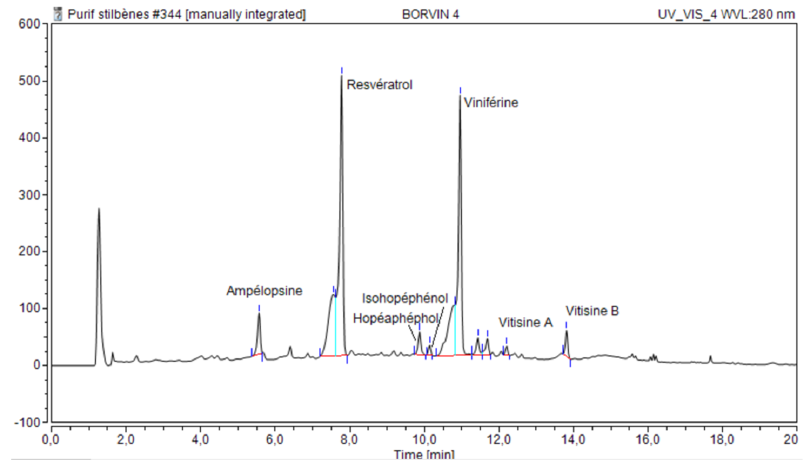
Figure 2. HPLC of concentrated aqueous polyphenol extract.